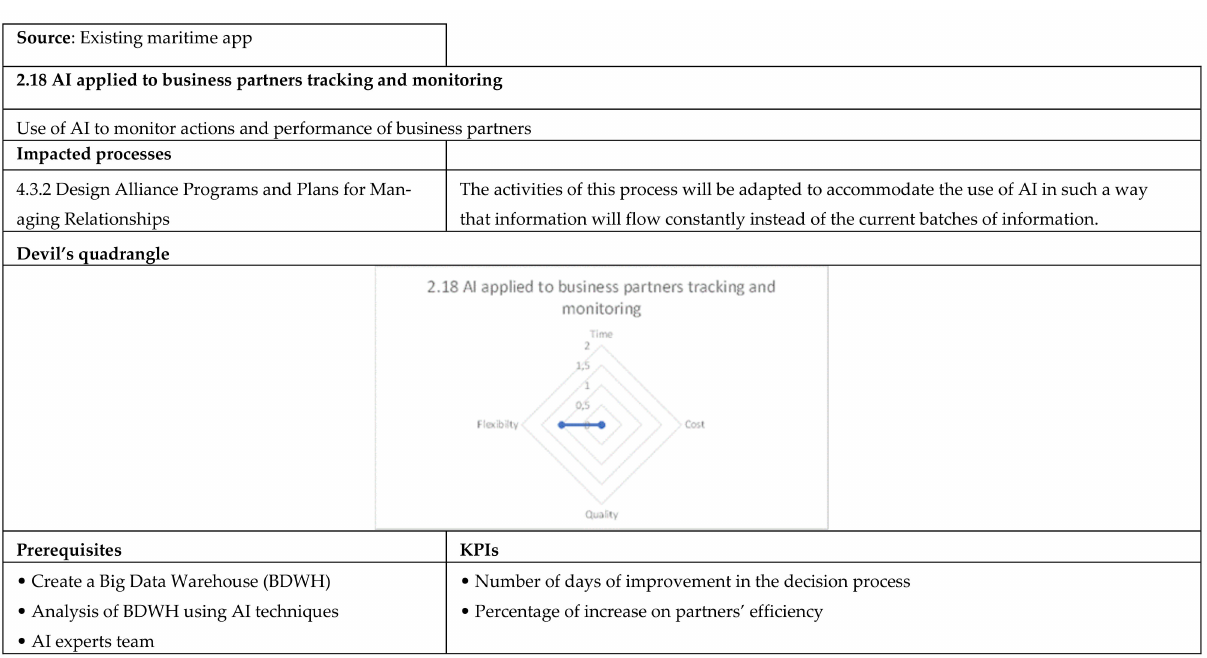
Figure A22. AI applied to business partners tracking and monitoring data